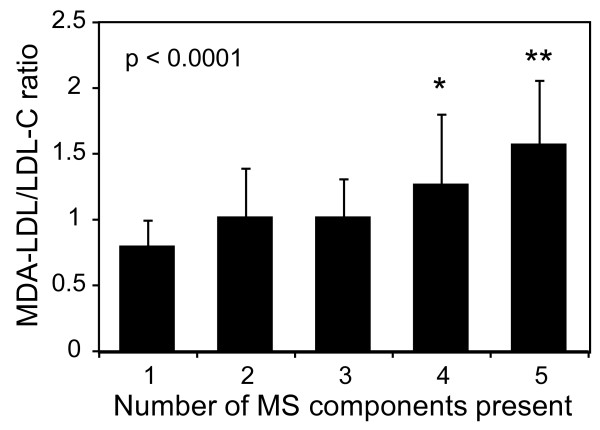
Association between the malondialdehyde-modified low-density lipoprotein (MDA-LDL)/LDL cholesterol (C) ratio and the number of metabolic syndrome (MS) components. The MDA-LDL/LDL-C ratios were compared in patients with the indicated number of MS components. Data are expressed as means ± SD. Statistical analyses were performed by analysis of variance with Tukey-Kramer’s honestly significant difference test. *, p < 0.05 vs. 1, 2, or 3; **, p < 0.001 vs. 1, 2, or 3.